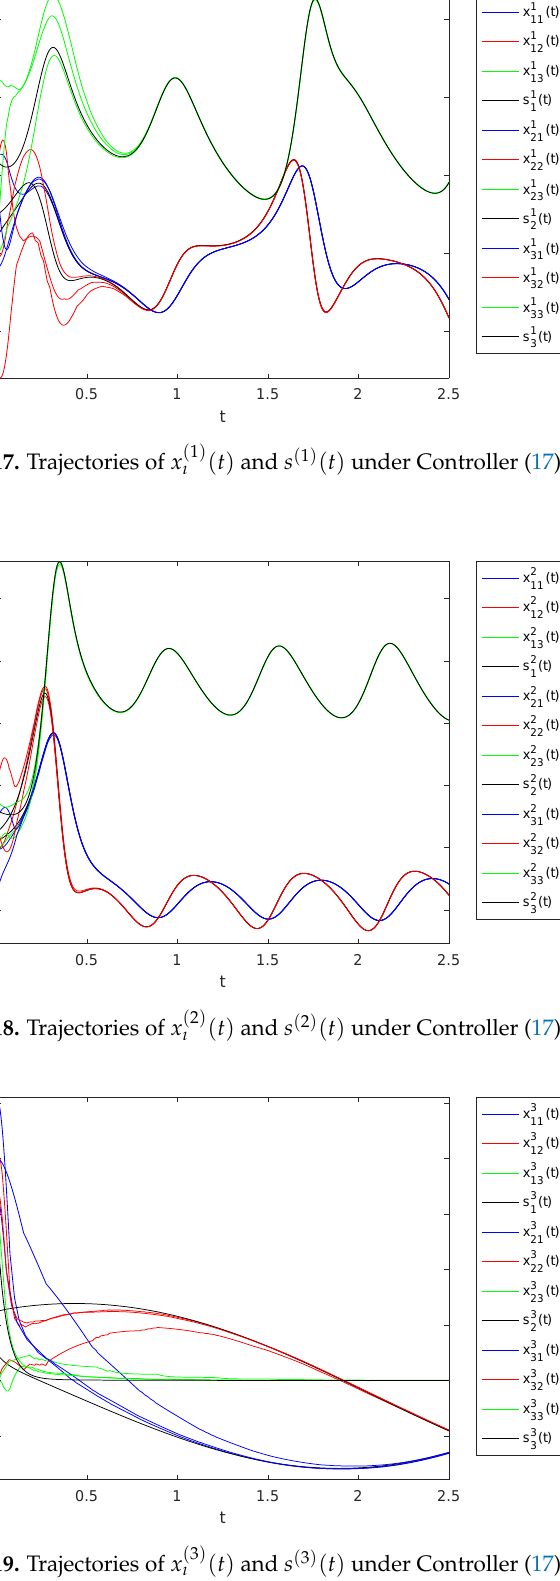
Figure 19. Trajectories of x